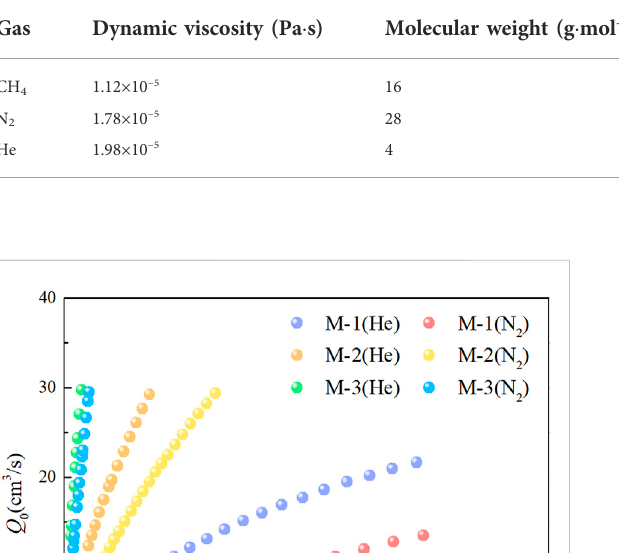
TABLE 2 Physical properties of the experimental gases.